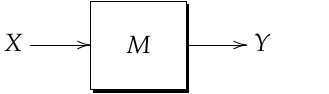
Figure 1. Associative memory as black